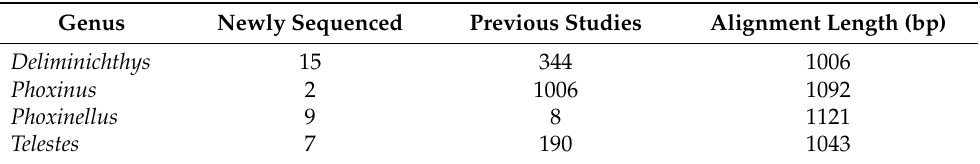
Table 1. An overview of sequences and alignment length of mitochondrial cytochrome b sequences used. Details are found in Table